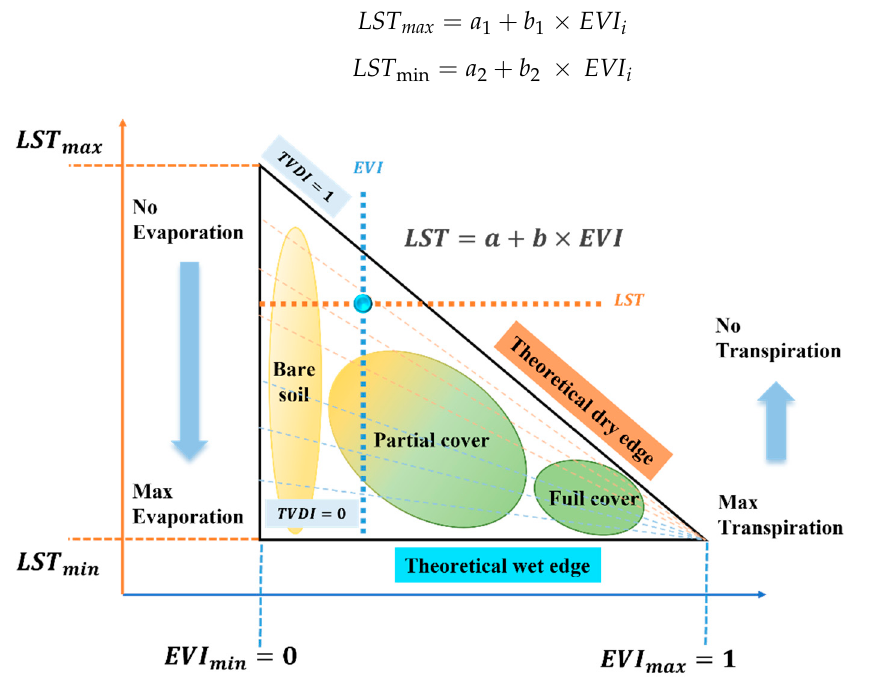
Figure 2. A schematic diagram of the TVDI estimation, adapted from Sandholt et al. [ 35 ] . Table 2. TVDI-based classification of drought and